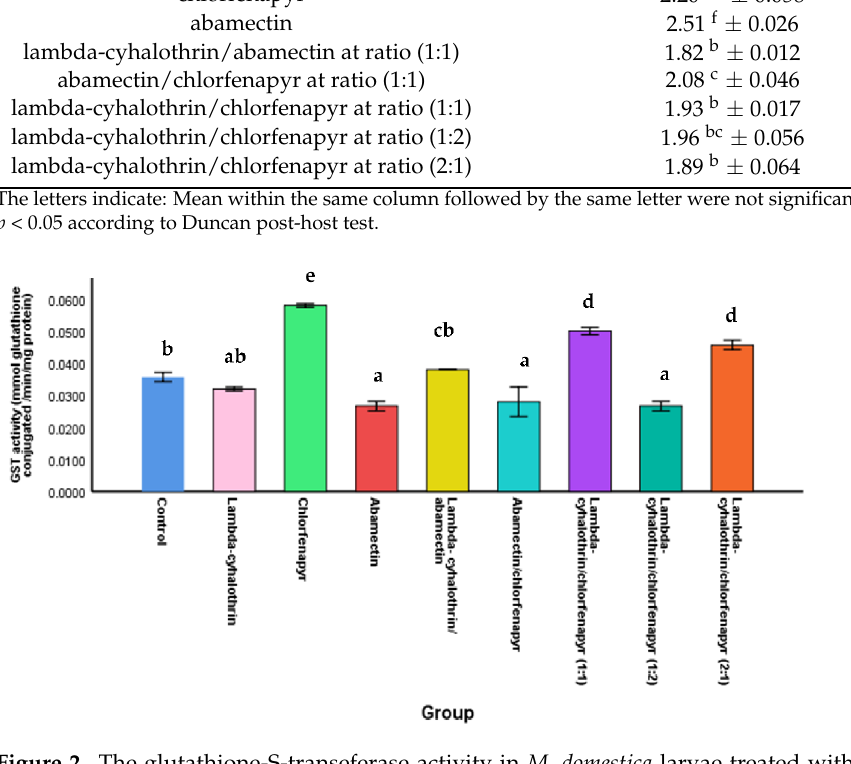
Figure 2. The glutathione-S-transeferase activity in M. domestica larvae treated with insecticides alone and combinations. Different letters indicate that the mean of GST activity within the same column followed by the same letter was not significantly different at p < 0.05 according to Duncan post-host test.